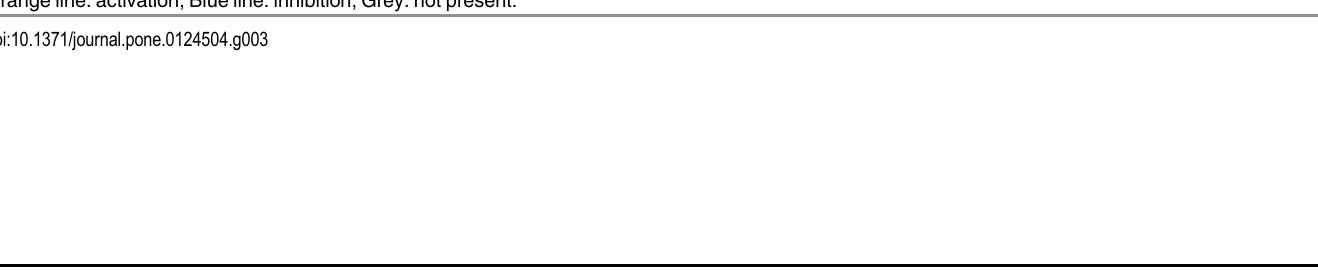
PLOS ONE | DOI:10.1371/journal.pone.0124504 April 30,